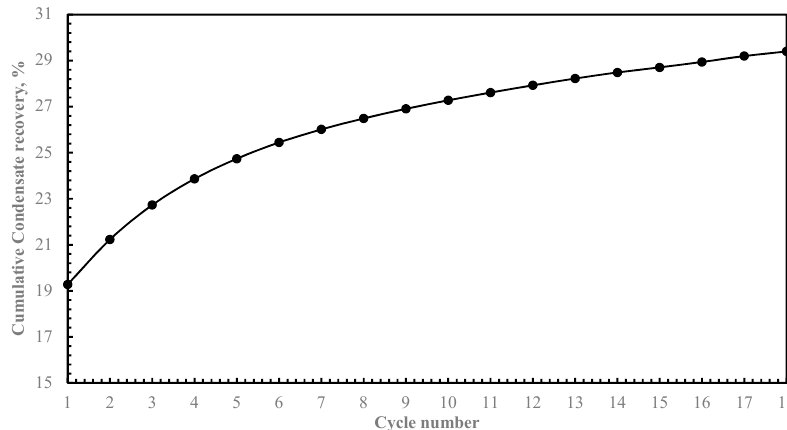
Figure 22. Cumulative condensate recovery at different cycle number.